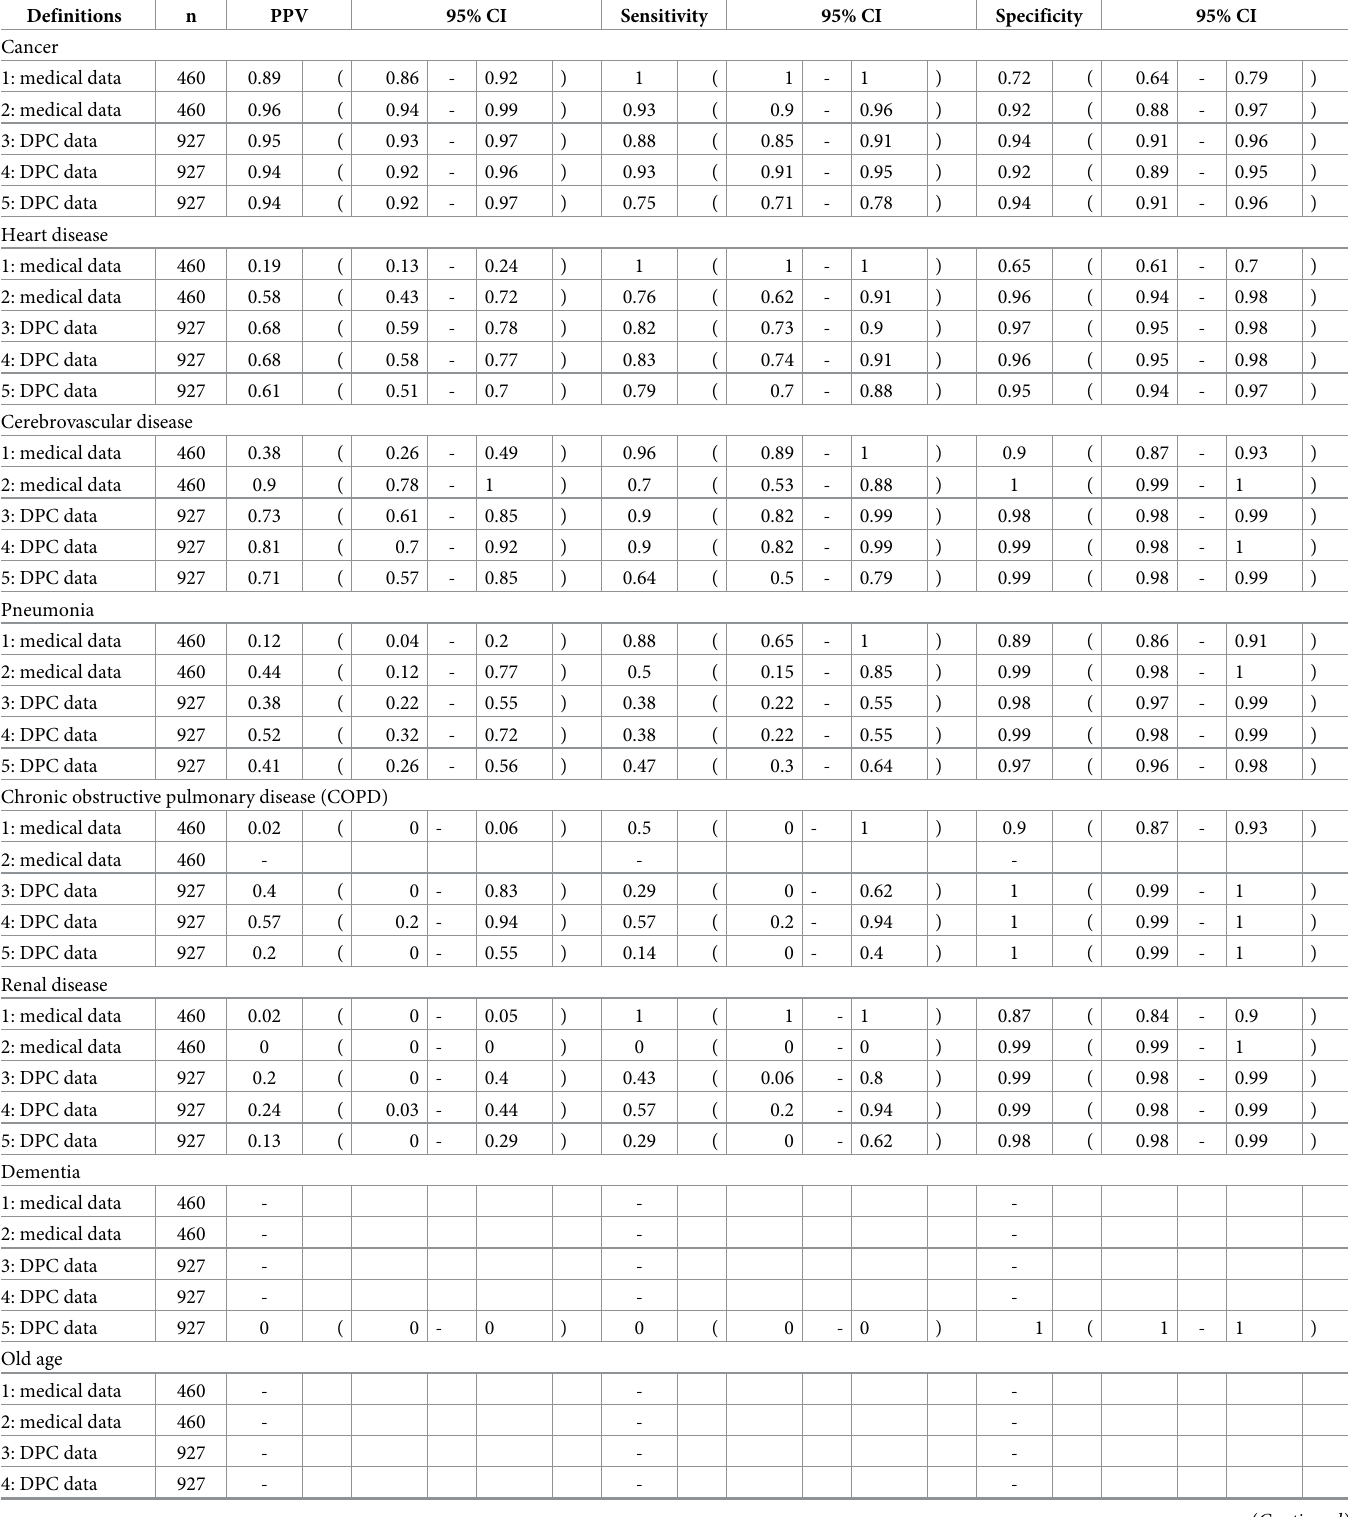
Table 3. Validity indices for the definitions of the cause of death based on claims data.